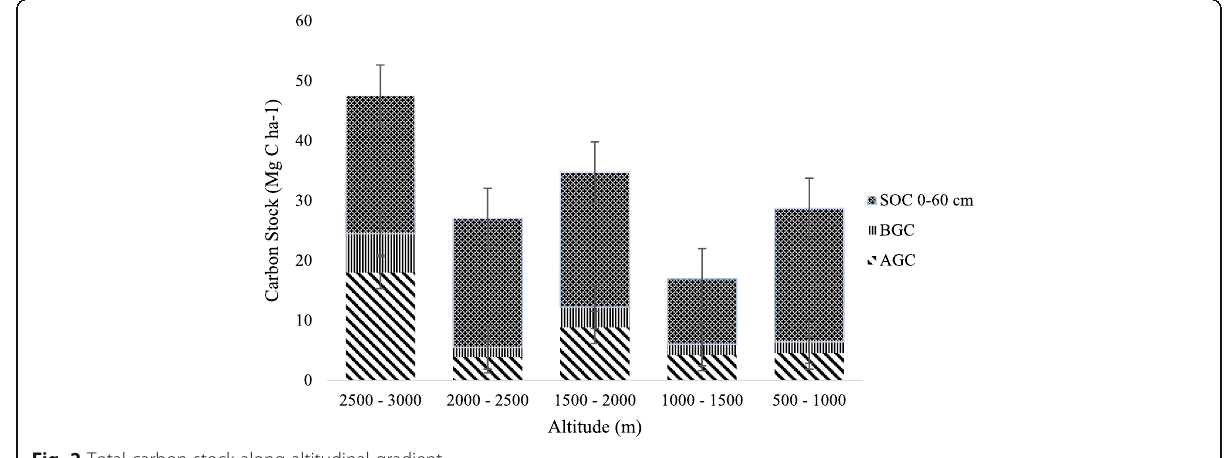
Fig. 2 Total carbon stock along altitudinal